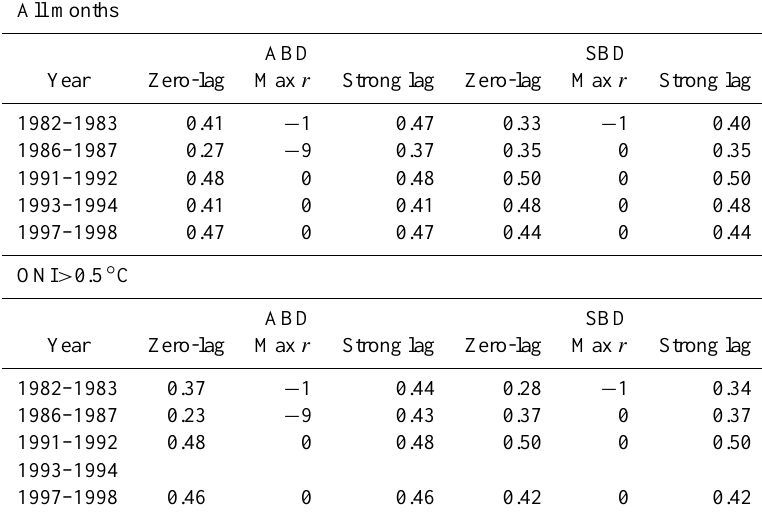
Table 3. Correlation ( r ) between monthly rainfall deficit (across all Borneo [ABD] and Southern Borneo [SBD]) and fire activity (active fire counts) during the five El Ni˜no events studied here; the two most significant in terms of El Ni˜no strength being those of 1982–1983 and 1997–1998. The upper table shows analyses based on all months during an El Ni˜no episode, the lower table only those months having ONI > 0.5 ◦ C (note: in 1993–1994 there were multiple periods with ONI > 0.5 ◦ C and so only the entire episode was analysed). Zero-lag is the strength of association at lag=0 months; Max r is the lag (in months) showing the strongest correlation, and Strong lag is the strength of the correlation in that